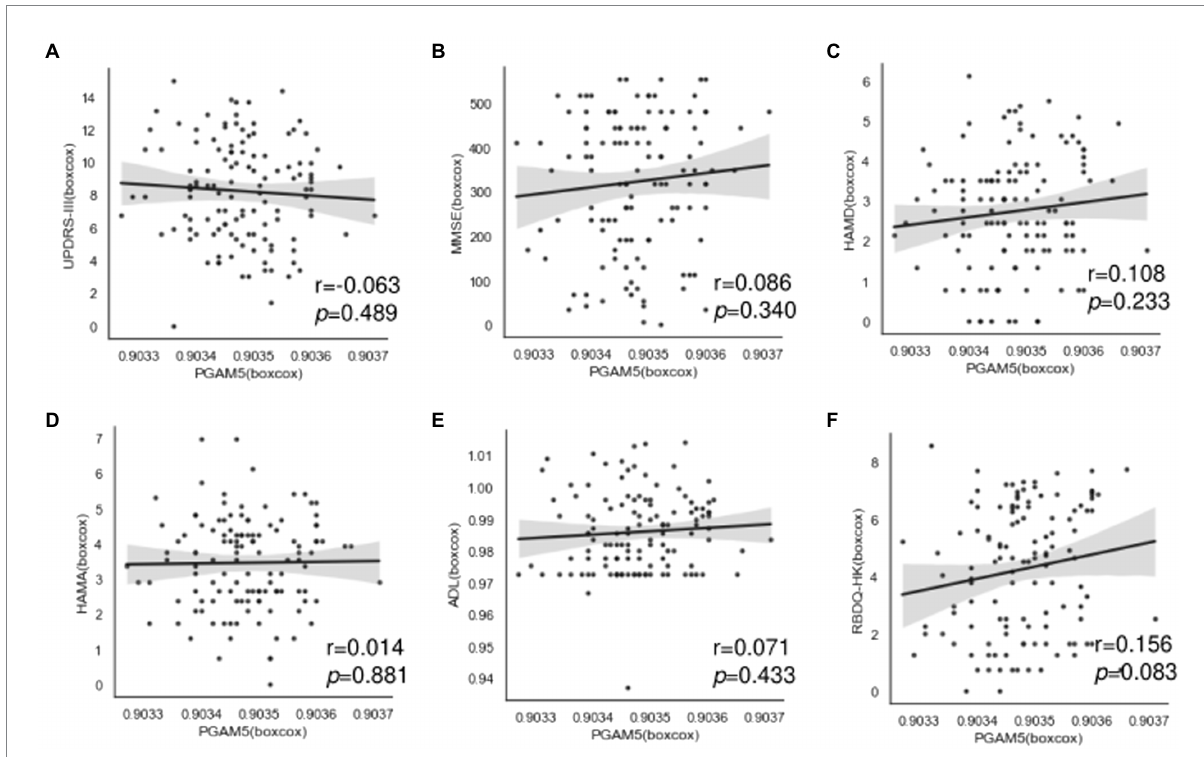
FIGURE 4 Correlation between plasma PAMG5 levels and scores of motor symptoms or non-motor manifestations in PD group, including: (A) UPDRS part III; (B) MMSE; (C) HAMD; (D) HAMA; (E) RBDQ-HK; (F) ADL ( r and p got by Pearson test, after Box-Cox